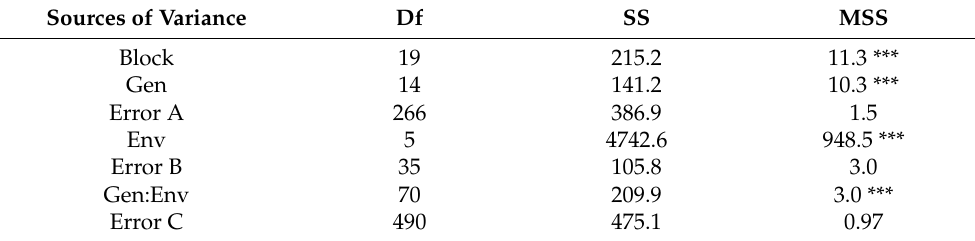
Table 3. Strip-plot analysis of variance for maize genotypes grain yield. Sources of